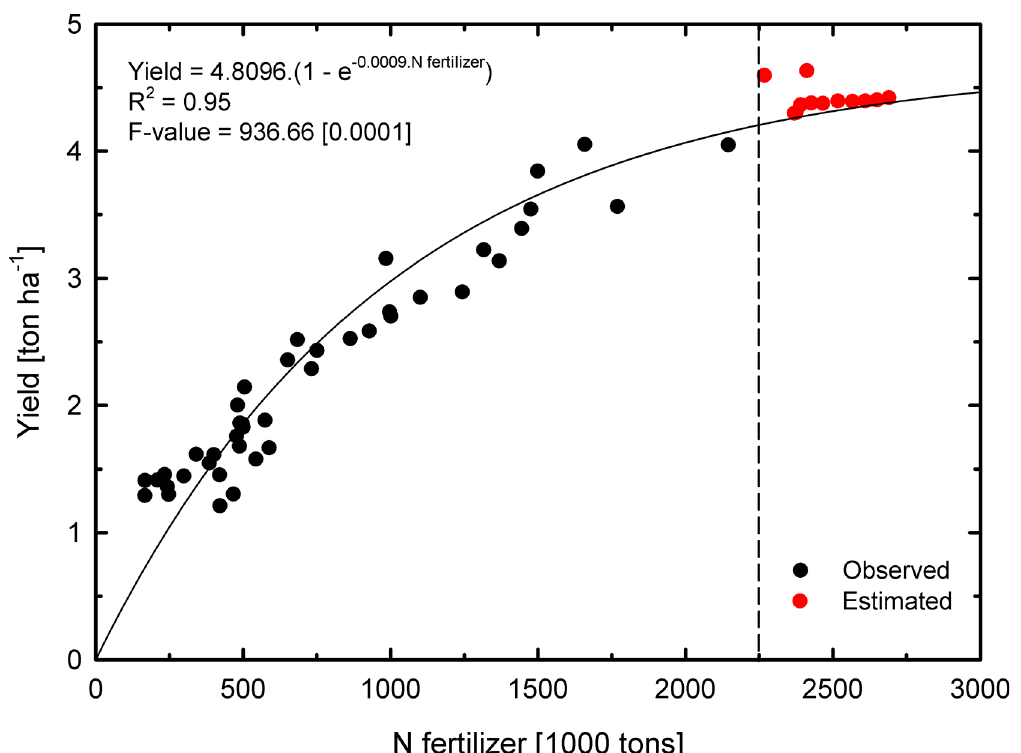
Fig 4. Effect of nitrogen fertilizer consumption on cereal yield for Brazil, 1970 – 2023. Observed (1970 – 2011) and estimated (2015 – 2023) relationships between N fertilization and yield. The trend line represents an exponential model fit. All coefficients were statistically significant at 1%. See S6 Table for additional details of ANOVA and Model